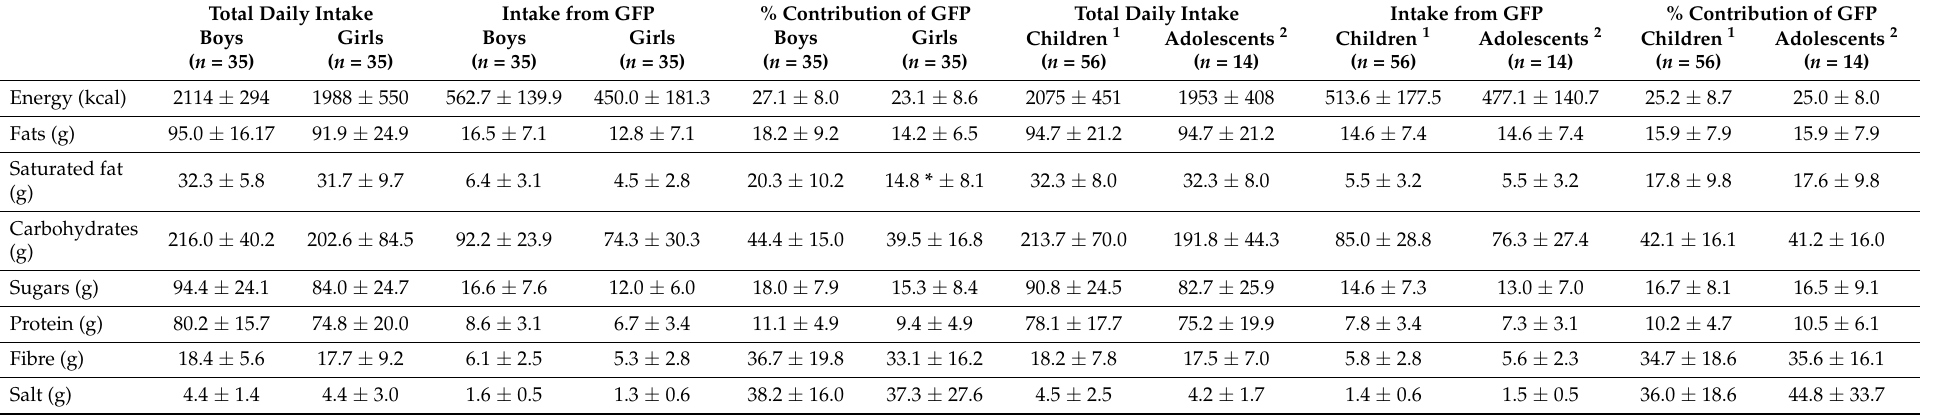
Table 3. Contribution of gluten-free products to the diet (energy and nutrient content) of Spanish children and adolescents with celiac disease depending on gender and